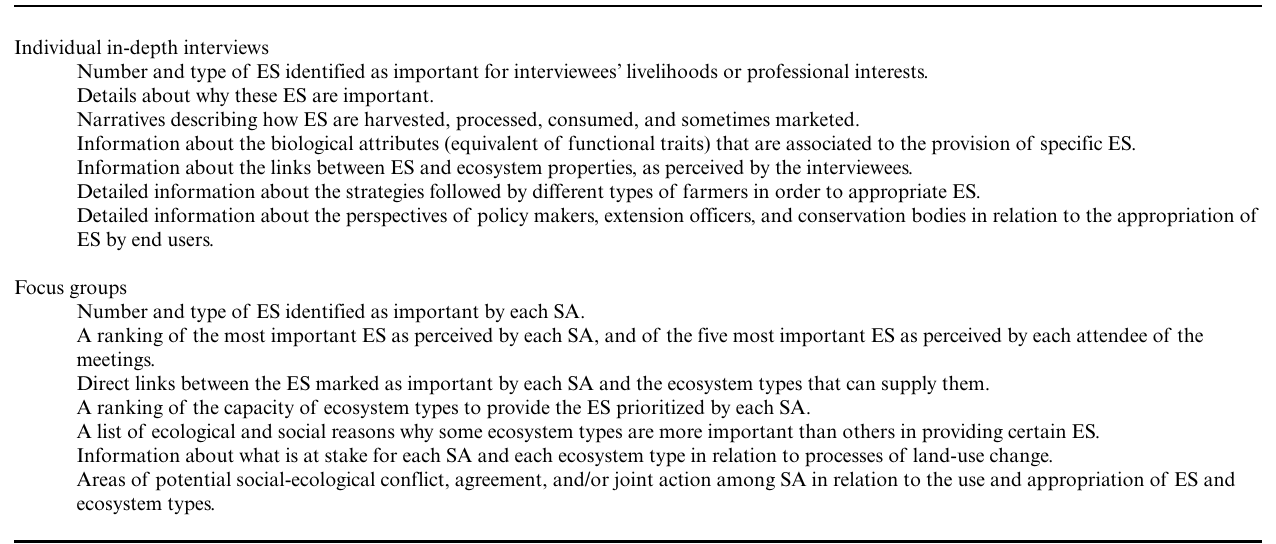
Table 1 . Nonexhaustive list of potential results that can be produced using the methodology summarized in Figure 1.